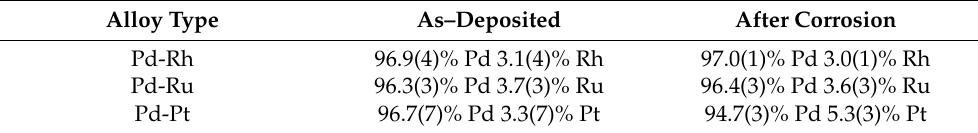
Table 1. Chemical compositions (EDX) of Pd-binary alloys before and after corrosion in